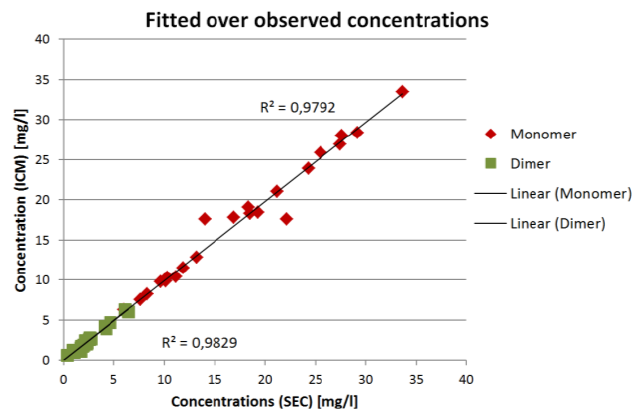
Figure 8. Concentrations based on fractionation and size exclusion chromatography (SEC) analyses compared to concentrations measured with inline concentration measurements (ICM).